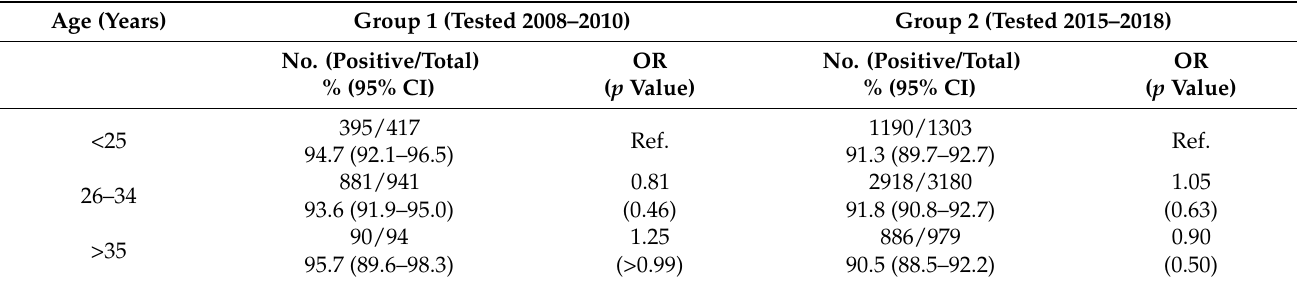
Table 2. Rubella seroprevalence among fertile women according to